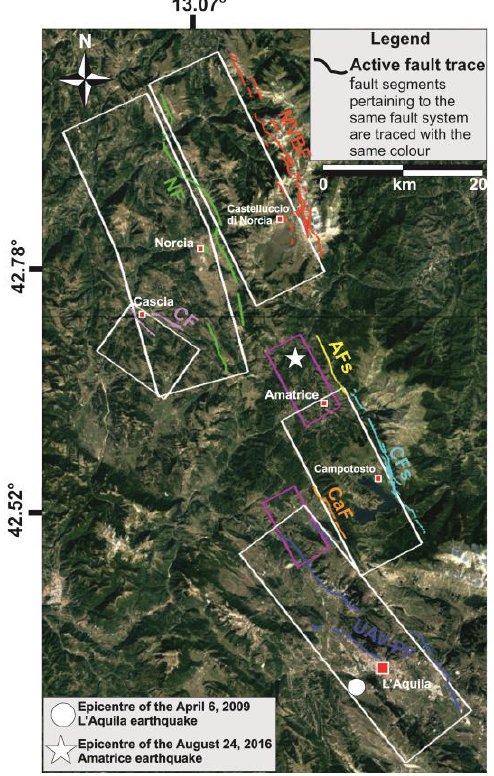
Figure 2. Map of the active faults of the region (col- oured lines). Faults: Mt.Vettore-Bove fault, MVBF; Norcia fault, NF; Cascia fault, CF; Amatrice fault segment, AFs; Campotosto fault segment, CFs; Capiti- gnano fault, CaF; Upper Aterno Valley-Paganica fault ststem, UAV-PF. Seismogenic sources, white boxes; Purple boxes indicate seismogenic sources not able to generate surface faulting